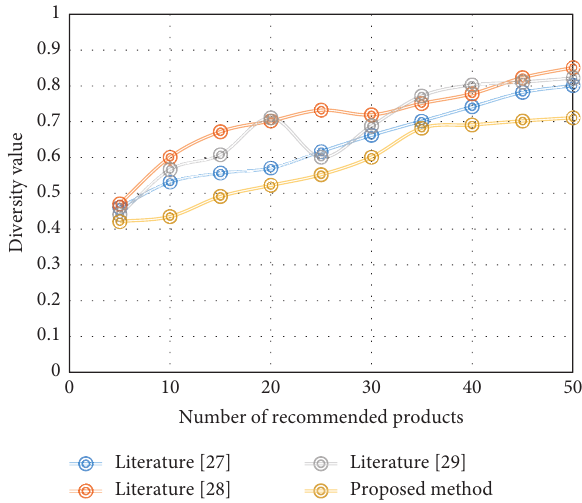
Figure 10: Diversity value of this algorithm and other algorithms.